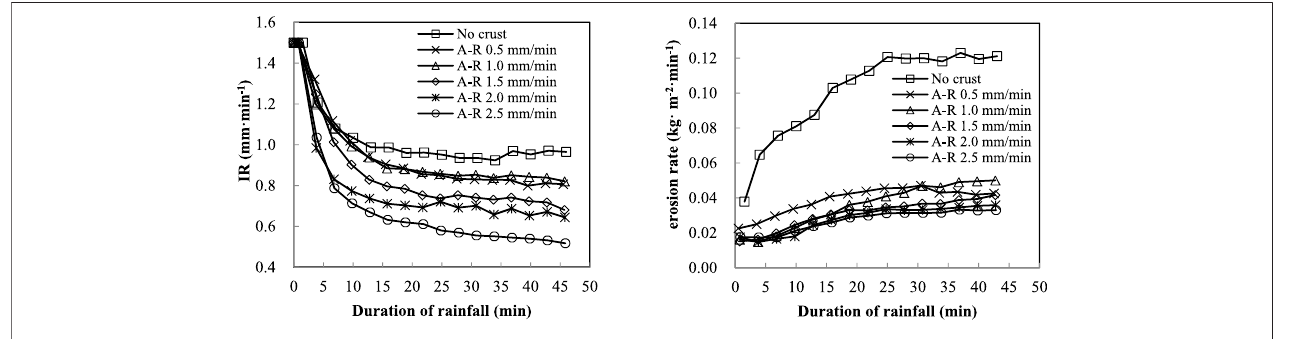
FIGURE 2 | Effects of antecedent crust on in fi ltration and sheet erosion rates. Notes: A-R means antecedent rainfall intensity.